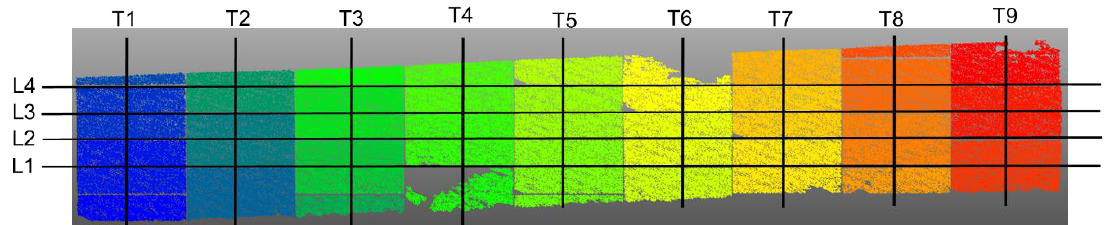
Figure 28. Longitudinal and transversal lines used for defining angular distortions for one of the faces of the MSE wall at Site-2. Remote Sens. 2020 , 12 , x FOR PEER REVIEW 26 of 30 Table 12. MLS-based summary statistics of the serviceability measures for 285 panels of the MSE wall at Site-2.